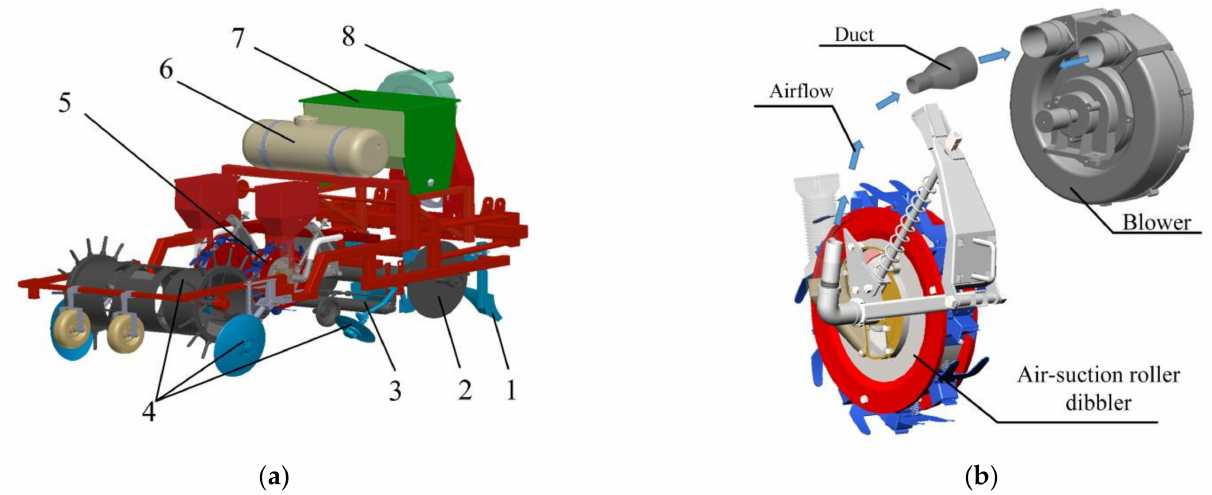
Figure 1. ( a ) Schematic diagram of film precision peanut seeder: (1) plough; (2) suppression roller; (3) film-spreading device; (4) mulching device; (5) seeding device; (6) spraying device; (7) fertilizer- application device; (8) blower; ( b ) structure of seeding